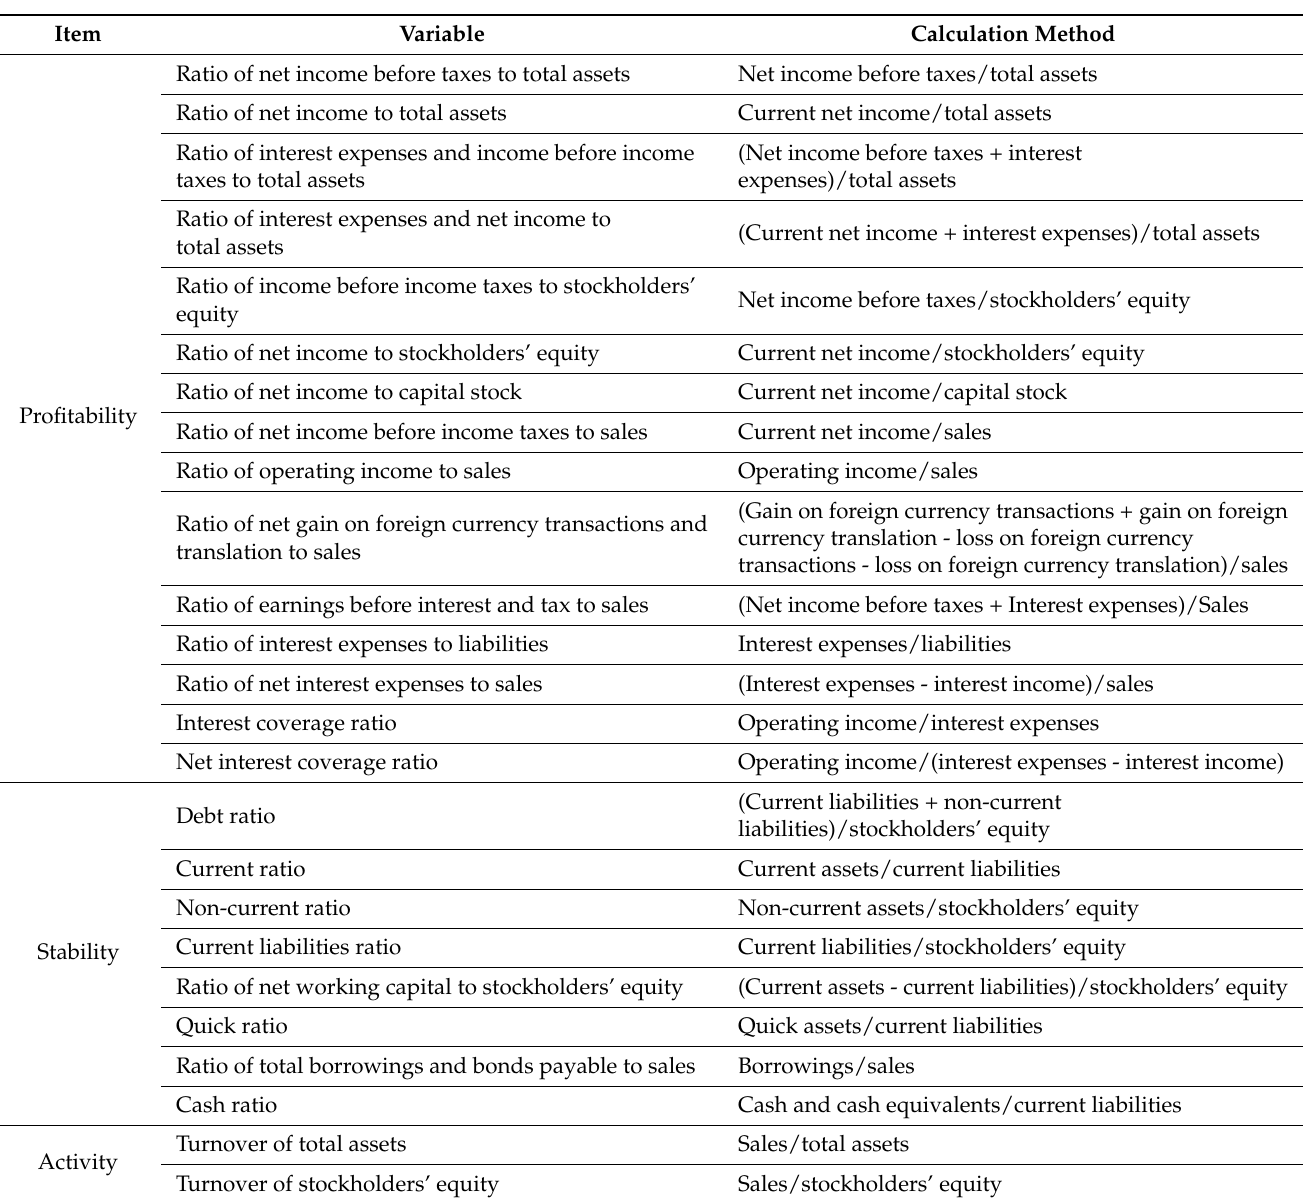
Table 2. Financial indicators from the Bank of Korea’s Financial Statement